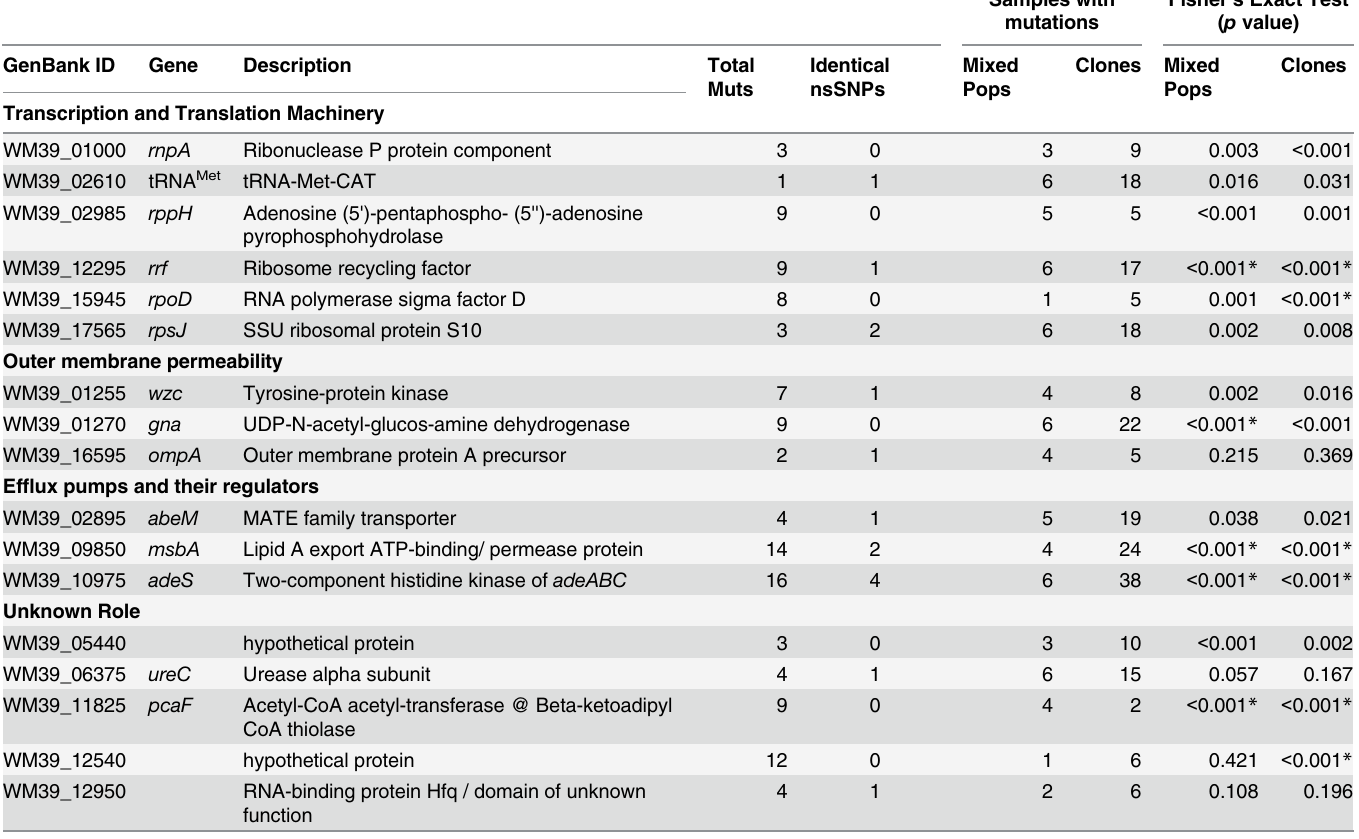
Table 2. Candidate TGC resistance